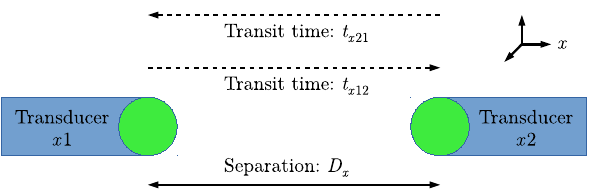
Figure 2. Diagram of a pair of a transducers from a sonic anemome-